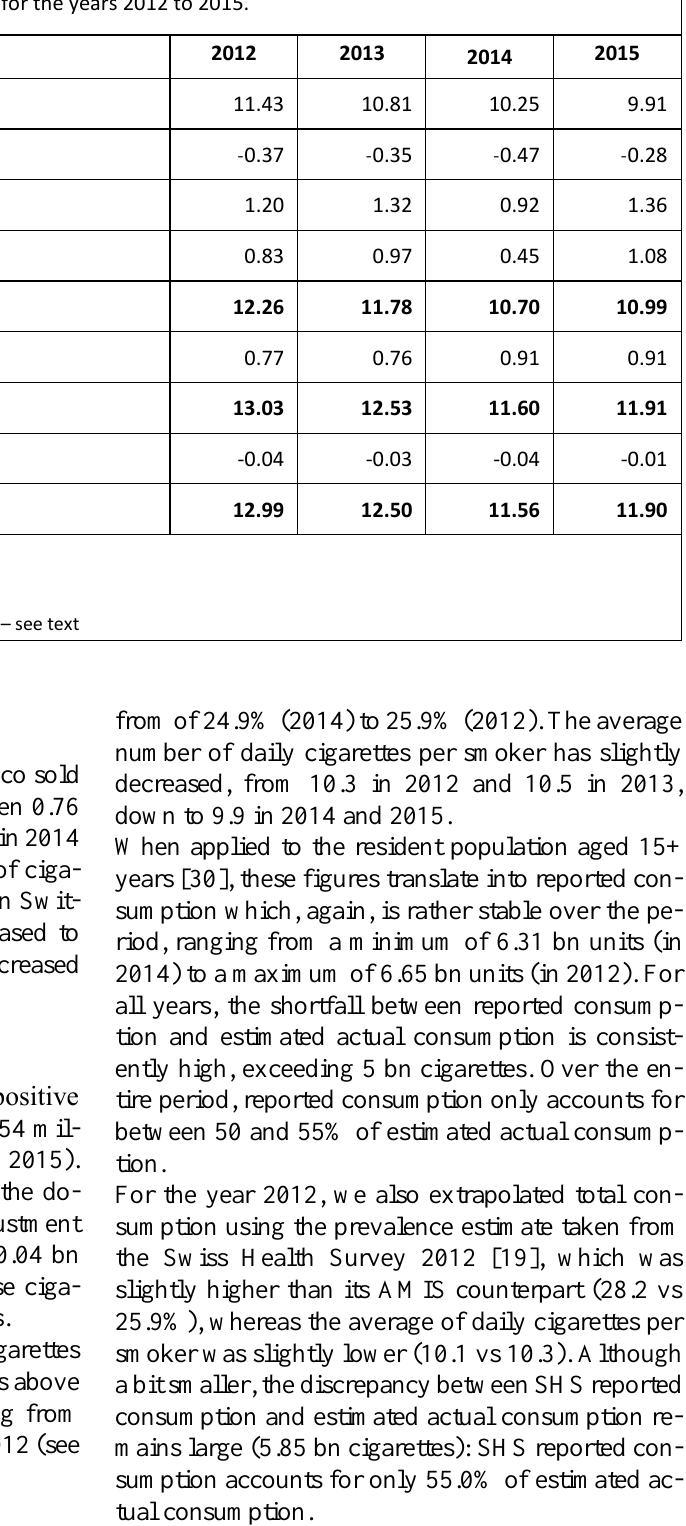
Table 1: Total cigarette consumption in Switzerland for the years 2012 to